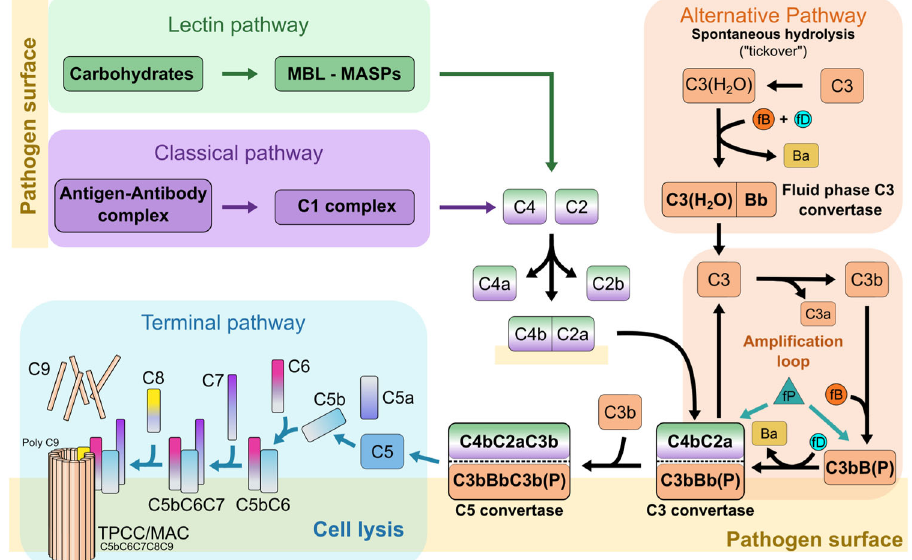
Fig.1|Overviewofthethreecomplementpathwaysandtheircomponents. The classical (CP) and the lectin pathway (LP) are triggered by speci fi c antigens on pathogen surfaces. The alternative pathway (AP) can start spontaneously by a nucleophilicattackofwateronmetastable native C3,resultinginthegenerationof the fl uid-phase C3 convertase, but it also serves as an ampli fi cation pathway after CPandLP.CPandLPsharethesameC3andC5convertasesCP/LPC4bC2aandCP/ LP C4bC2aC3b, respectively. Analogue to C3b of the AP C3 convertase, CP/LP